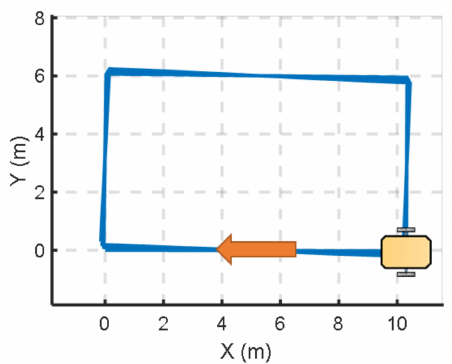
Figure 6. The real-world mixed working cycle pathways.